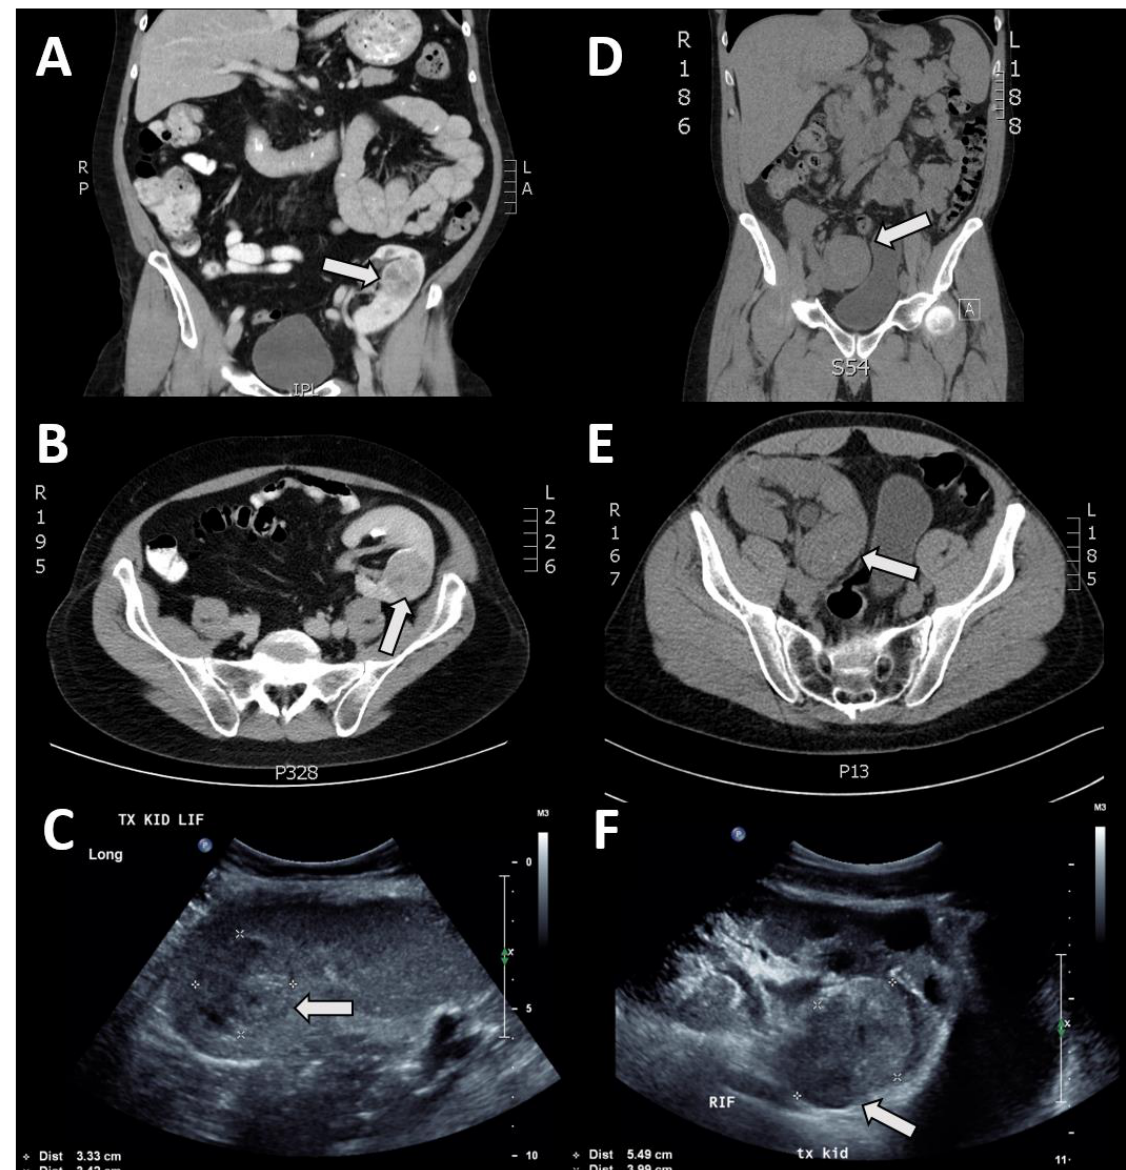
Figure 1. A . Computer tomographic scan (CT) case 1: coronal section showing transplant kidney in left iliac fossa; distinct mass present in upper pole and enhanced with contrast, designated by arrow. B . CT case 1: transverse section showing distinct mass in transplant kidney enhanced with contrast, predominantly posteriorly located. C . Ultrasound case 1: showing distinct mass within kidney. D . CT case 2, coronal section showing transplant kidney in right iliac fossa; indiscriminate mass located in lower pole without contrast enhancement. E . CT case 2, transverse section showing indiscriminate mass in posterior portion of kidney. F . Ultrasound case 2, showing distinct mass in posterior portion of kidney